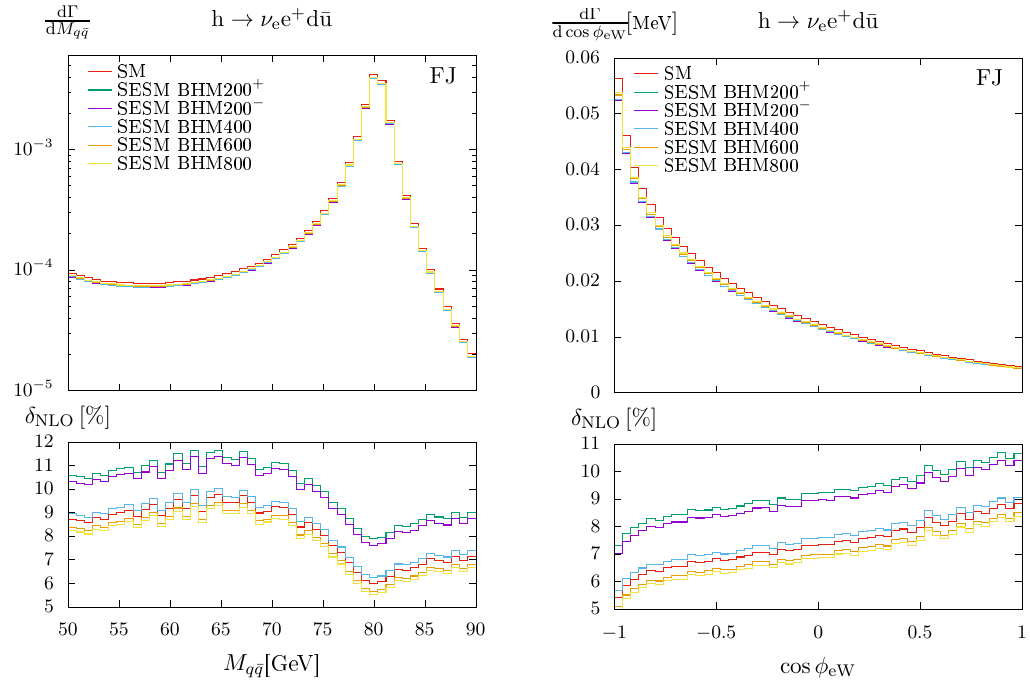
Figure 24 . Invariant-mass and angular distributions for the charged-current semi-leptonic decay h ! (cid:23) e e + d(cid:22)u, in the FJ renormalization scheme for the various SESM scenarios. SESM and the SM is given by an o(cid:11)set, which depends on the considered scenario and is equal to the di(cid:11)erence obtained for the corresponding integrated